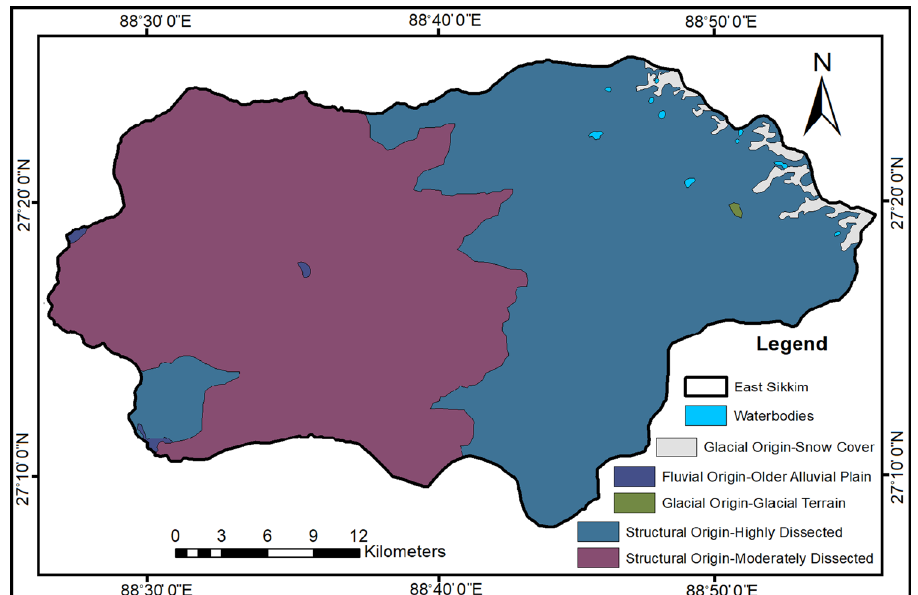
Fig. 6 Geomorphology map